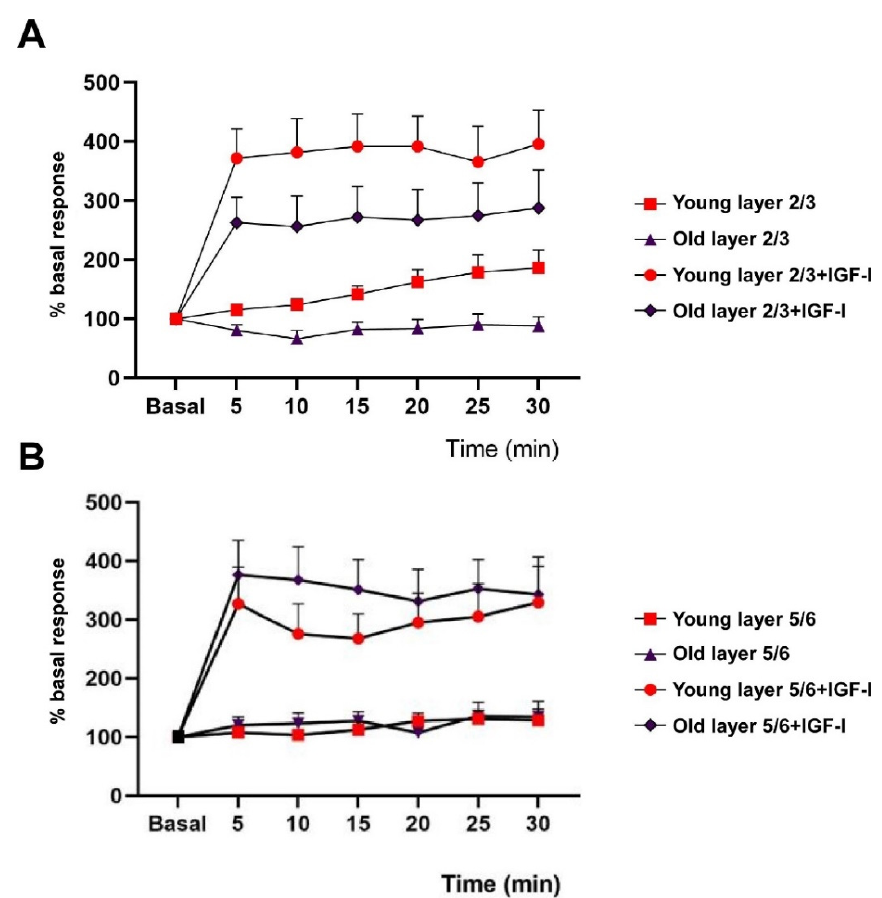
Figure 3. IGF-I increases the response facilitation evoked by the application of the stimulation train. ( A ) In layer 2/3, young mice showed a significant response increase after the stimulation train in the presence of IGF-I (Two-Way Repeated Measure ANOVA, group factor: F (1,128,6) = 139.5; p < 0.001). A similar effect was found in old animals (Two-Way Repeated Measure ANOVA, group factor: F (1,154) = 80.89, p < 0.001). However, the response increase in the presence of IGF-I was significantly lower in old animals (Two-Way Repeated Measure ANOVA, group factor: F (1,161) = 12.48; p = 0.0005). ( B ) A similar effect was observed in layer 5/6 neurons. In the presence of IGF-I, the response to whisker stimulation increased in young animals (Two-Way Repeated Measure ANOVA, group factor: F (1,203) = 37.12, p < 0.001) and in old ones (Two-Way Repeated Measure ANOVA, group factor: F (1,147) =